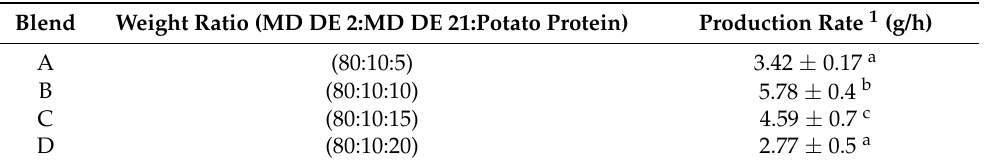
Table 1. Production rate for each blend (weight ratio per 100 mL double distilled water), expressed as mass of fibers (g) spun per hour (h), with standard deviations.